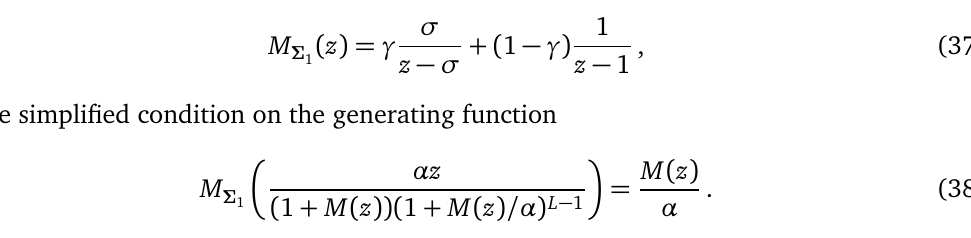
Figure 3: Eigenvalue densities for structured Wishart product matrices for depths L = 1 ( left ) and L = 2 ( right ) of width α ture is as described in the main text, with M Σ γ = 1 / 8 and varying signal eigenvalues σ , indicated by shades of purple. Solid lines show the result of solving equation (36) numerically, while shaded areas show the results of numerical eigendecompositions of matrices of size n each empirical histogram is obtained for a single realization of the random